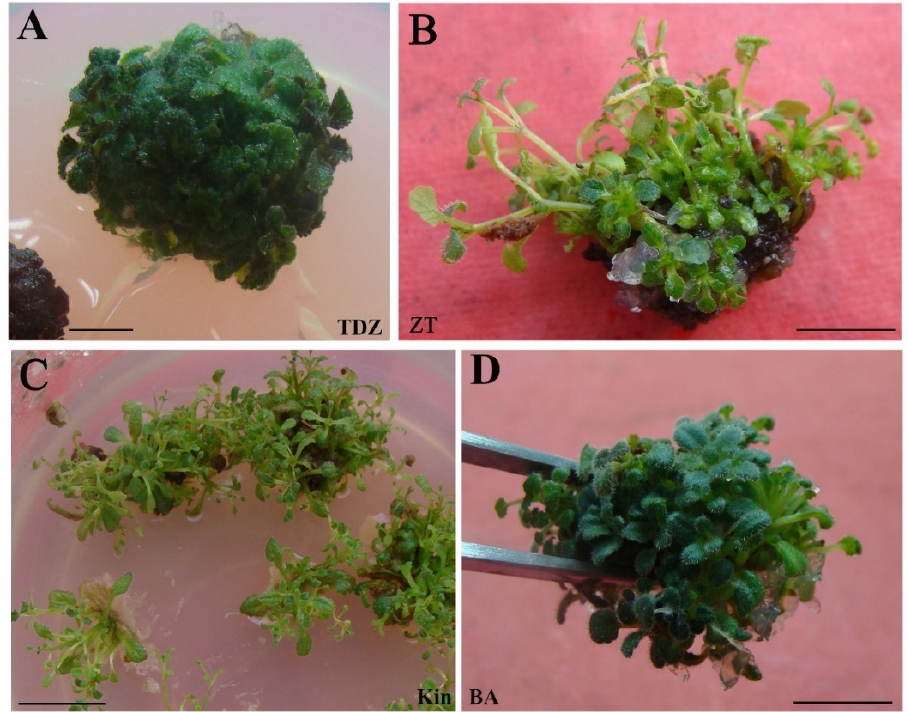
Figure 1. Impact of cytokinins on direct adventitious bud regeneration of Sinningia hybrida ‘Isa’s Murmur’. Adventitious shoot formation on 2.0 mg L − 1 TDZ ( A ), ZT ( B ), Kin ( C ), and BA ( D ) medium after four weeks of culture. Bar = 5 mm ( A ), 2 cm ( B ), 1 cm ( C , D ).